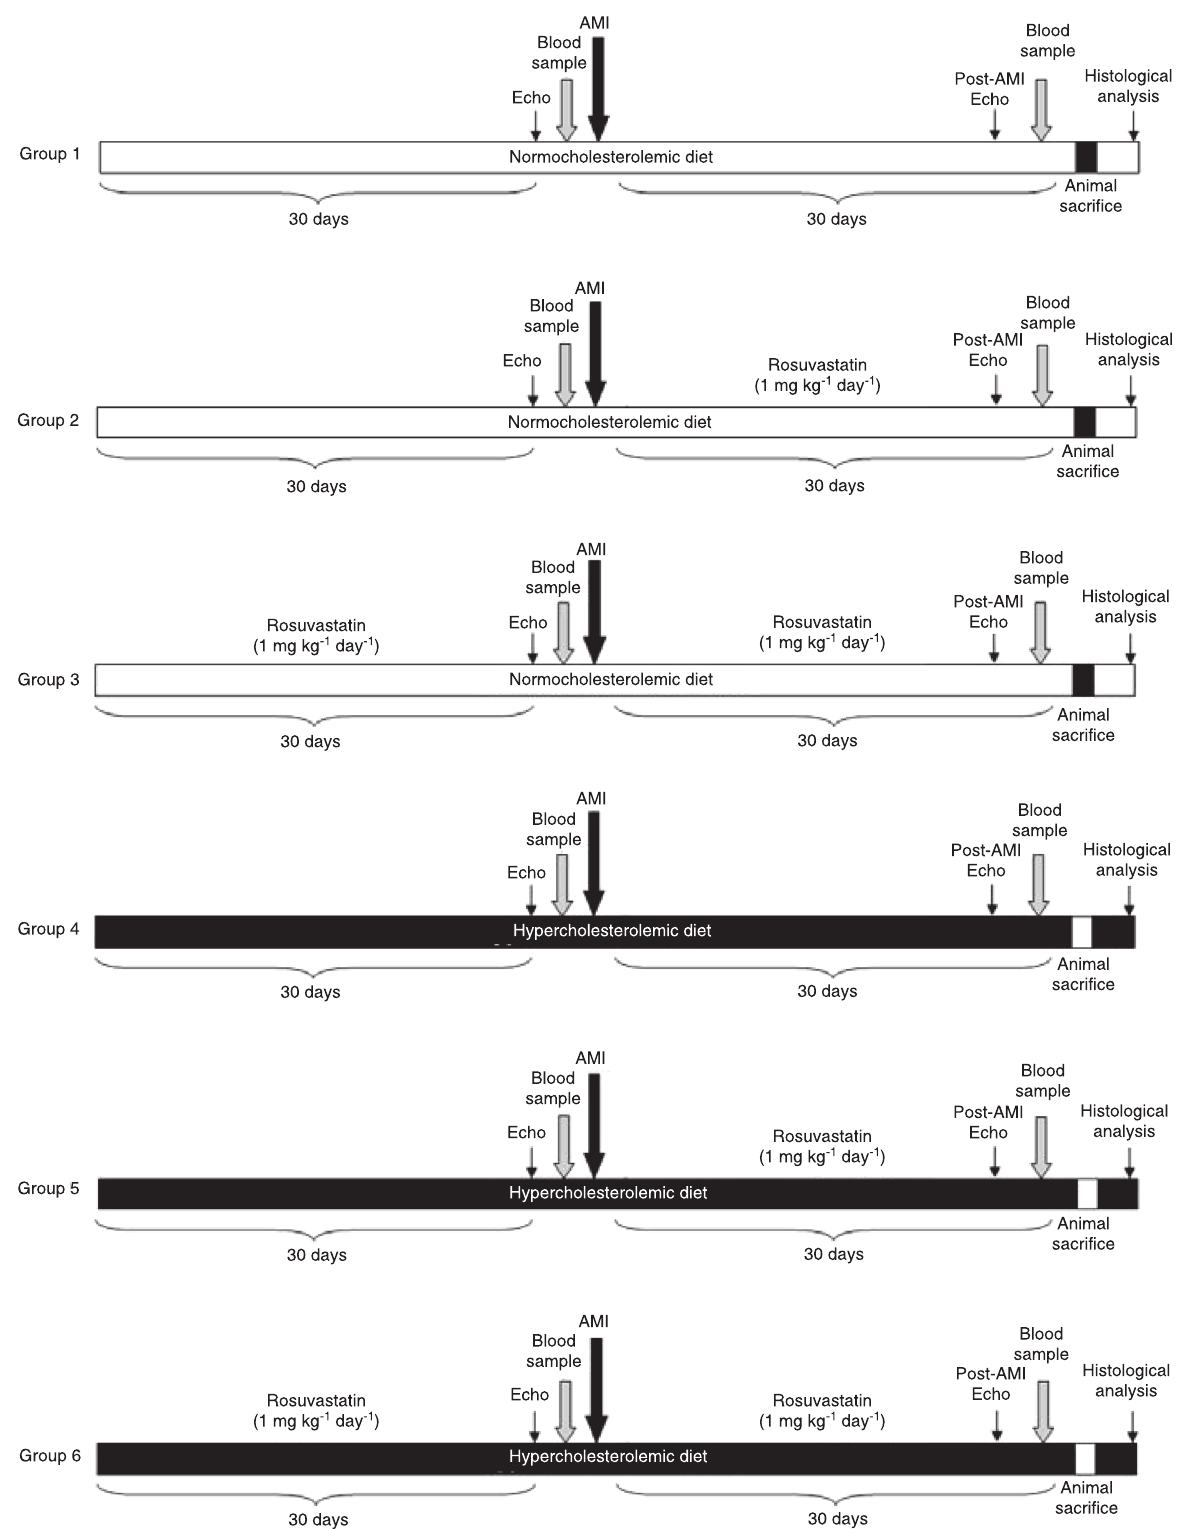
Figure 1. Experimental protocol. AMI = acute myocardial